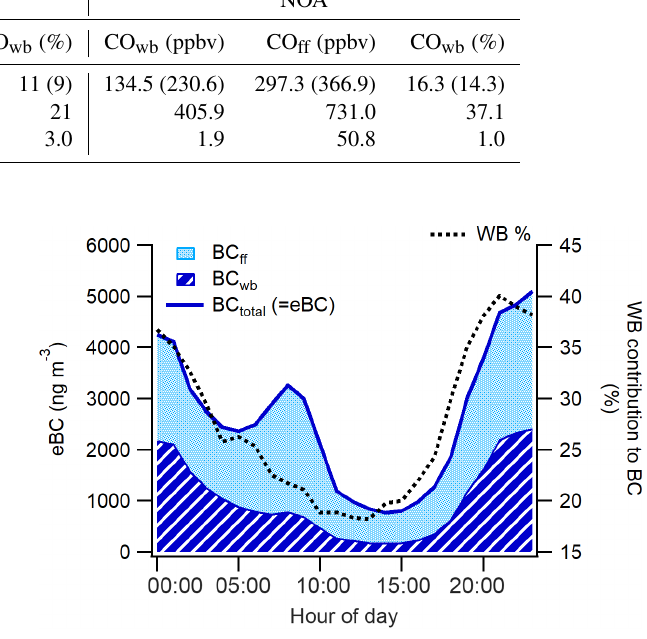
Figure 5. Diurnal cycle of BC wb , BC ff , BC total and wood burning contribution to total BC (WB, defined as BC wb / BC total · 100) at DEM station.